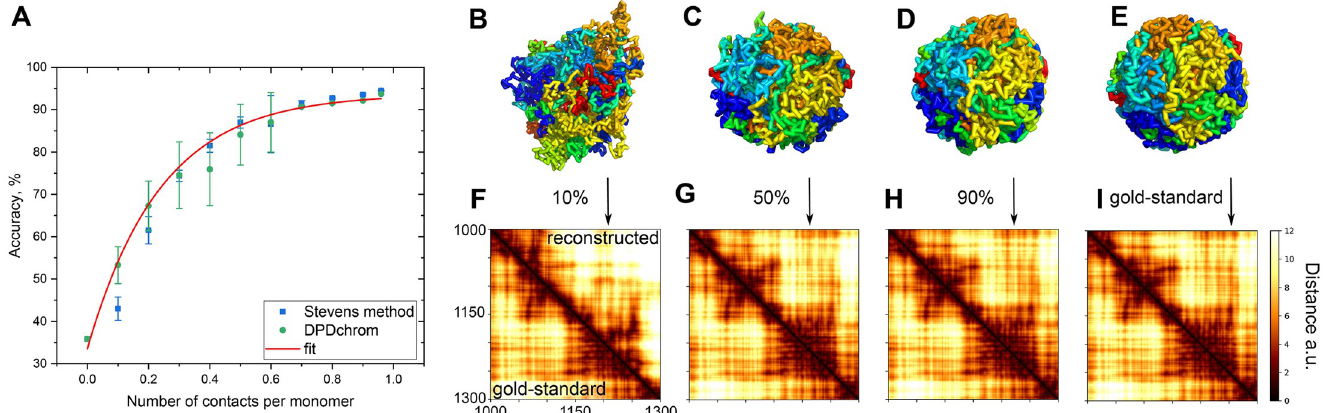
Fig 4. A . Dependence of the reconstruction accuracy on the number of contacts per bead. DPDchrom and the Stevens method were applied to reconstruct globule using a fraction of contacts within the range [0, 100]%. The red line represents the exponential fit for DPDchrom. B-D . Reconstructed 3D conformations using 10%, 50%, 90% of contacts, colored by rainbow from the first to the last bead. E . Gold-standard 3D conformation, colored as in (B-D). F-H . Distance maps of the gold standard (lower left triangle) and the reconstructed (upper right triangle) conformations using 10%, 50%, 90% of contacts. I . Distance map of the gold-standard conformation (both